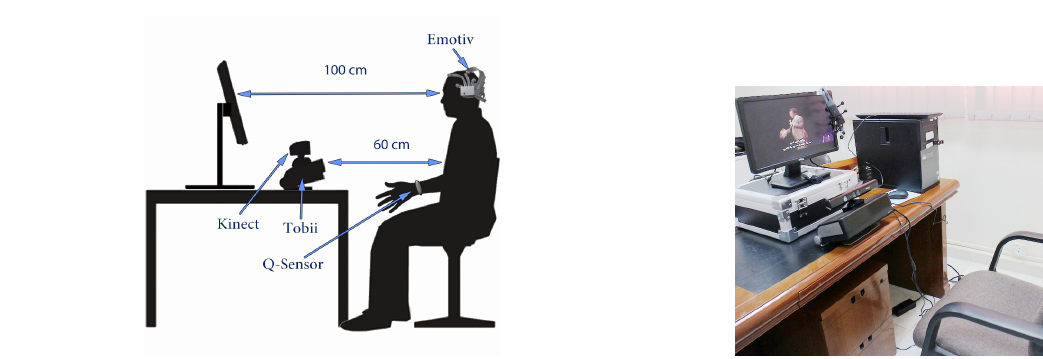
Figure 3. The estimated AUs from Microsoft Kinect SDK.